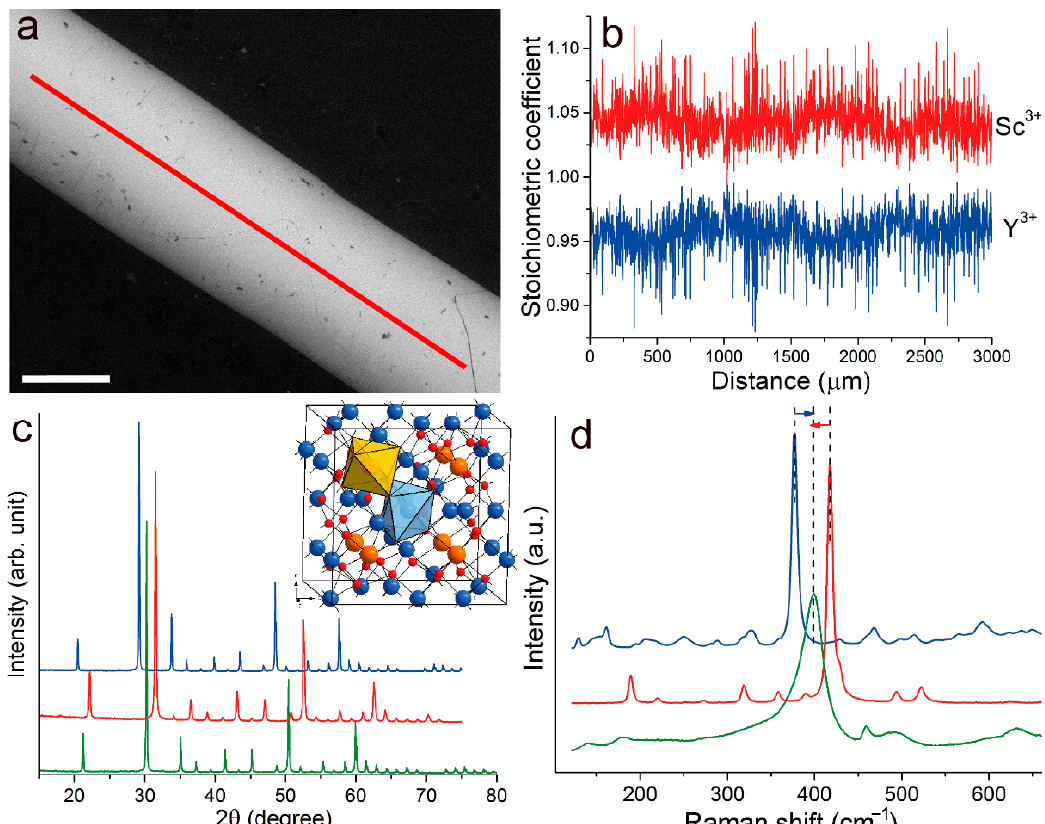
Figure 1. ( a ) An image of the YScO 3 crystal fiber captured in backscattered electron mode (BSE). A scalebar is 0.5 mm; ( b ) Stoichiometric coefficients of Y 3+ (blue one) and Sc 3+ (red one) ions calculated based on three oxygen atoms per formula unit; ( c ) The X-ray pattern of the YScO 3 crystal fiber (green one) and Y 2 O 3 and Sc 2 O 3 precursors (blue and red ones, respectively). Insert: bixbyite-type crystal structure of YScO 3 . Symmetrically diverse M O 6 polyhedra both centered by statistically distributed Y 3+ and Sc 3+ ions are shown as orange ( C 3 i site) and blue ( C 2 site); red balls are O atoms; ( d ) Raman spectra of Y 2 O 3 and Sc 2 O 3 precursors and YScO 3 crystal fiber (blue, red and green lines, respectively). Table 1. Miller indices ( hkl ), interplanar distances d , Bragg angles 2 θ and Bragg peak intensities I of Structural characteristics of the crystal fiber, as well as powders of Y 2 O 3 and Sc 2 O 3 the Y 2 O 3 , Sc 2 O 3 and YScO 3 with a bixbyite-type structure. Y 2 O 3 ; a = 10.604(1) 1c, insert). The lattice parameters of YScO 3 , Y 2 O 3 and Sc 2 O 3 were obtained as a (YScO 3 ) = 10.228(1) Å, a (Y 2 O 3 ) = 10.604(1) Å and a (Sc 2 O 3 ) = 9.841(4) Å, respectively. Due to the low concentration of Nd 3+ and Tm 3+ ions in the YScO 3 host (about 0.1 at. %), RE impurity does